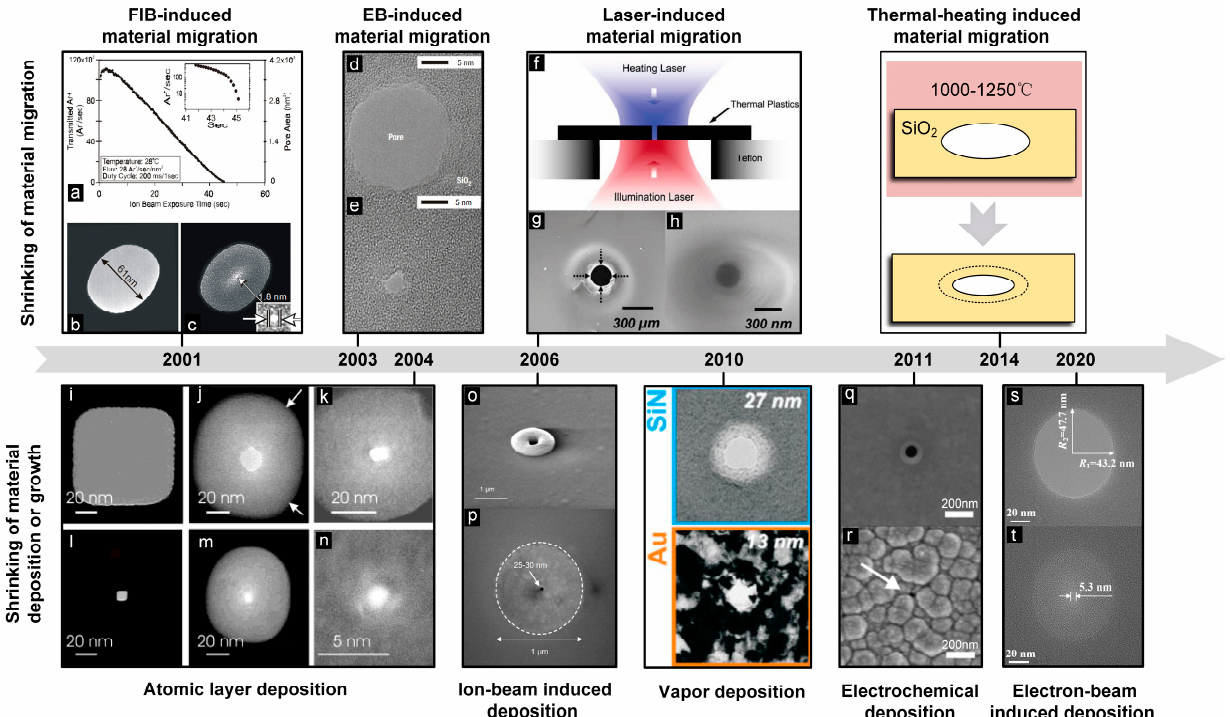
Figure 1. The timeline of typical shrinkage manufacturing technologies. Shrinking of original material migration: FIB-induced material migration [23], ( a ) Transmitted ion count rate and pore area, ( b ) 61nm pore, ( c ) after ion beam exposure; EB-induced material migration [33], ( d ) Before shrinking, ( e ) After shrinking; Laser-induced material migration [35], ( f ) A schematic, ( g ) Before shrinking, ( h ) After shrinking; Thermal-heating induced material migration [36]. Shrinking of new material deposition or growth: Atomic layer deposition [38], ( i , k , m ) Before shrinking, ( j , l , n ) After shrinking; Ion-beam induced deposition [44], ( o ) Before shrinking, ( p ) After shrinking; Vapor deposition [45]; Electrochemical deposition [46], ( q ) Before shrinking, ( r ) After shrinking; Electron-beam induced deposition [37], ( s ) Before shrinking, ( t ) After shrinking.